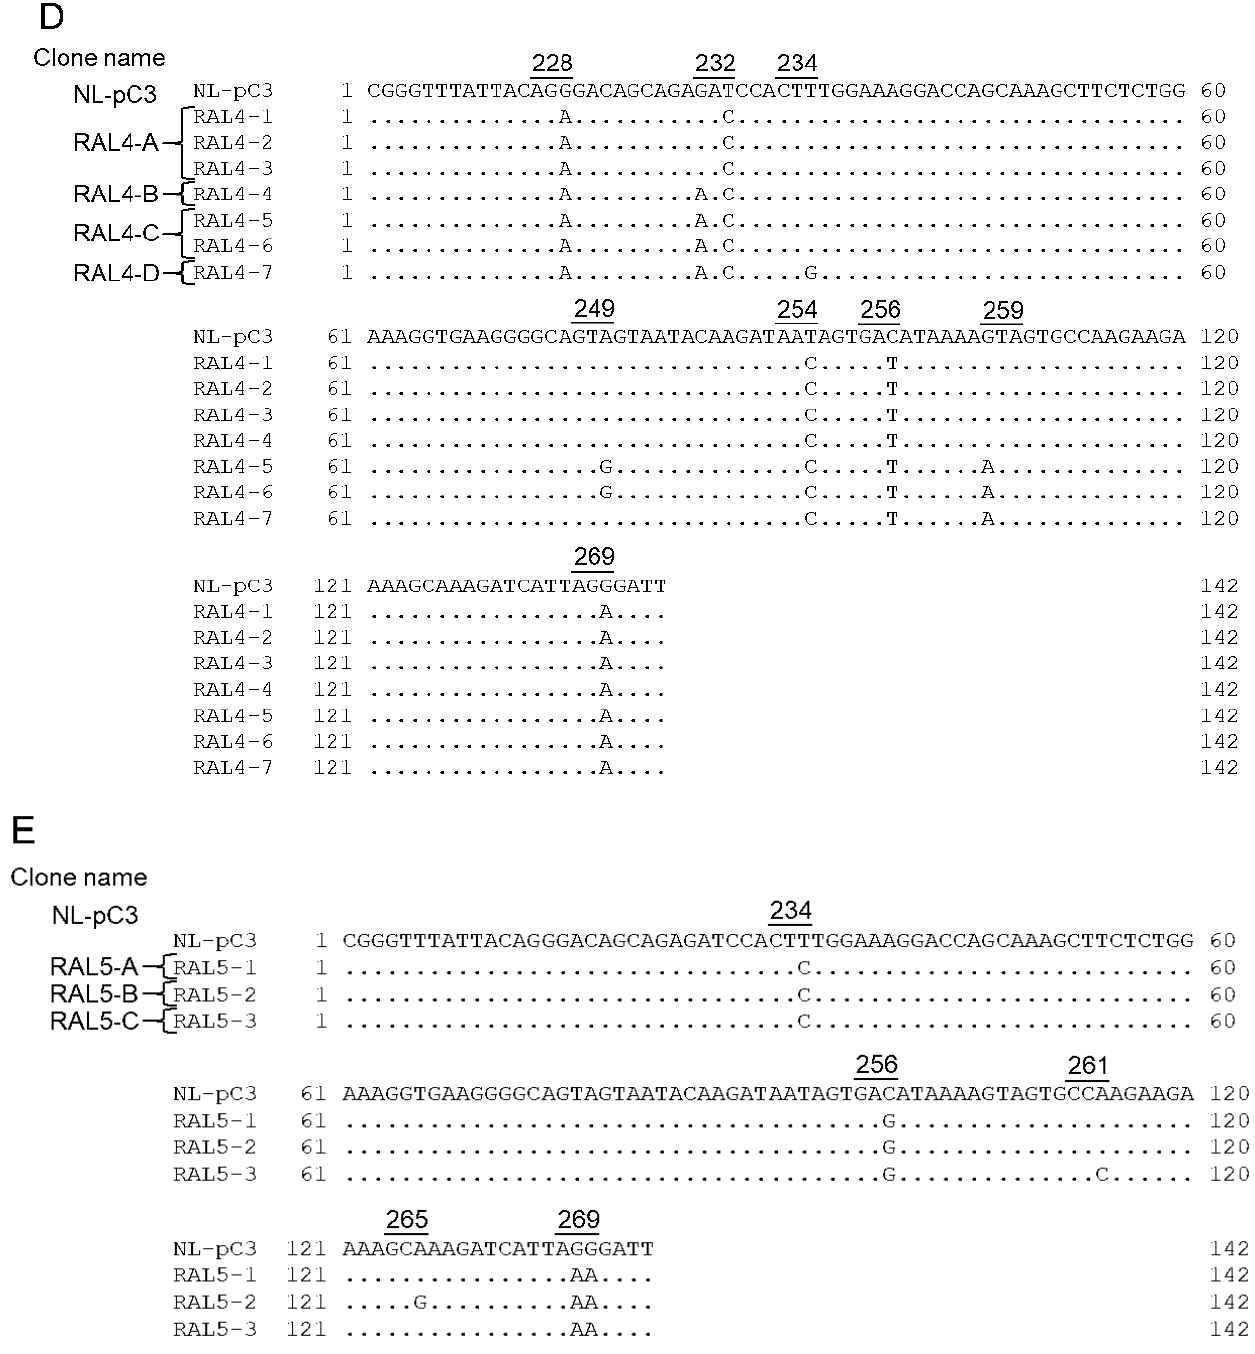
Figure 9. SA1D2prox sequences of NL4-3, its derivatives, and clinical samples. Sequence alignments were carried out using Genetyx Ver. 15. Numbers and underlines above the sequences represent Pol-IN amino acid positions (NL4-3 numbering) and codons, respectively. ( A ) Sequences of NL4-3, NL-pC2, and NL-pC3. NL-pC2 and NL-pC3 clones have 2 and 3 nucleotide substitutions, respectively, which are major nucleotides at each position in the SA1D2prox sequence within the HIV-1 subtype B population. ( B , C ) Chronological changes of the SA1D2prox sequence in samples obtained at different time points from PI-resistant patients PI1 ( B ) and PI4 ( C ). Sequence data were published previously [55] (DDBJ; PRJDB3502). Clone name was designated PI1-A, -B, and -C ( B ) and PI4-A, -B, -C, and -D ( C ) based on the sequence identity. ( D , E ) Chronological changes of the SA1D2prox sequence in samples obtained at different time points from RAL-resistant patients RAL4 ( D ) and RAL5 ( E ). Sequence data were published previously [55] (DDBJ; PRJDB3502). Clone name was designated RAL4-A, -B, and -C ( D ) and RAL5-A, -B, and -C ( E ) based on the sequence identity and the chronological order.